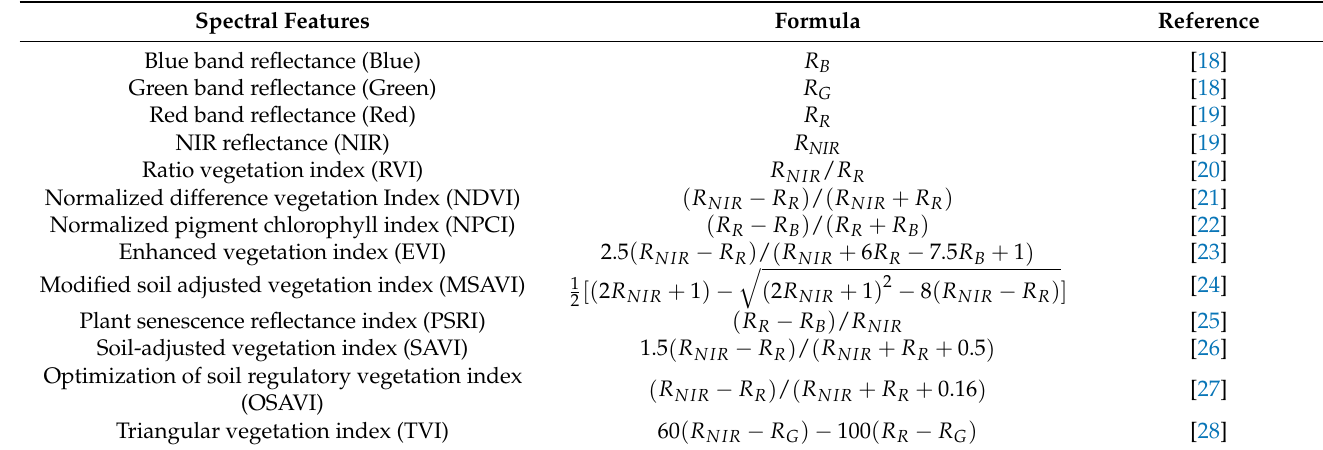
Table 2. Selected spectral